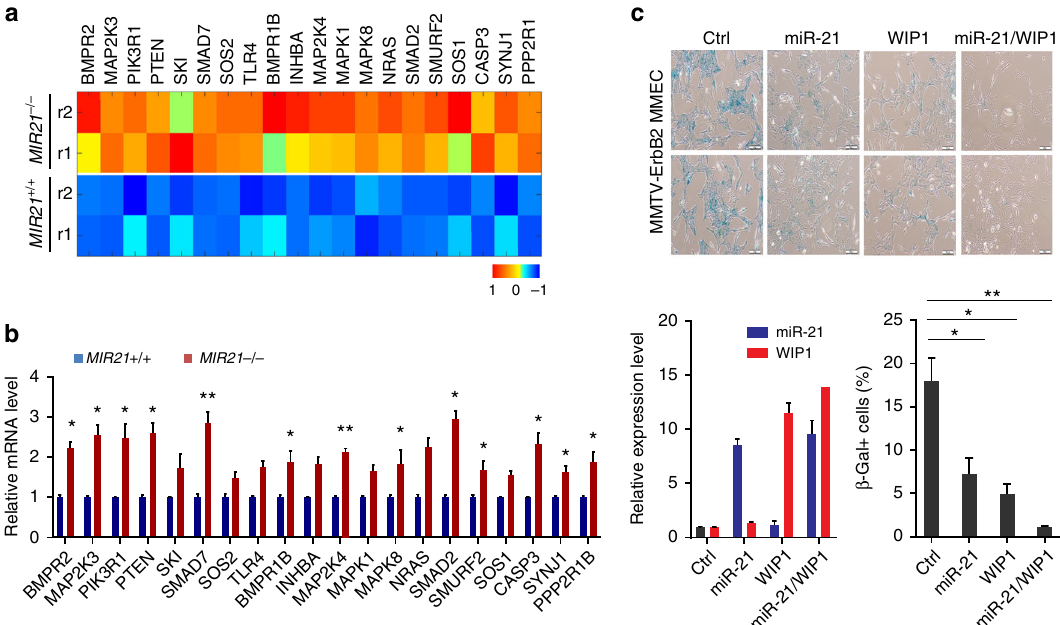
Fig. 3 Overexpression of miR-21 and WIP1 promotes oncogenic transformation of HER2 + breast cancer cells. a The differential expression heat map of miR-21 target genes in the mammary epithelial cells (MMECs) derived from MIR21 − / − ;MMTV-ErbB2 mice (8 weeks old). b Relative expression levels of the predicted miR-21 targets in primary MMECs isolated from wild-type or MIR21-/- virgin females at the age of 8 weeks. Data represents the mean expression levels normalized to the endogenous snoRNA55 control from three independent experiments. c MMECs derived from MMTV-ErbB2 mice were transduced with lentivirus expressing miR-21 and/or WIP1. Top panel: representative photomicrographs of SA- β -galactosidase (SA- β -Gal) staining observed in bright fi eld. Bottom panel: miR-21 and WIP1 expression levels as determined by q-PCR, and percentages of SA- β -Gal-positive cells were calculated. Scale bar, 10 µ m. * p < 0.05; ** p < 0.01; unpaired 2-tailed t -test was used ( b , c ). Data are presented as mean ± SD and are representative of